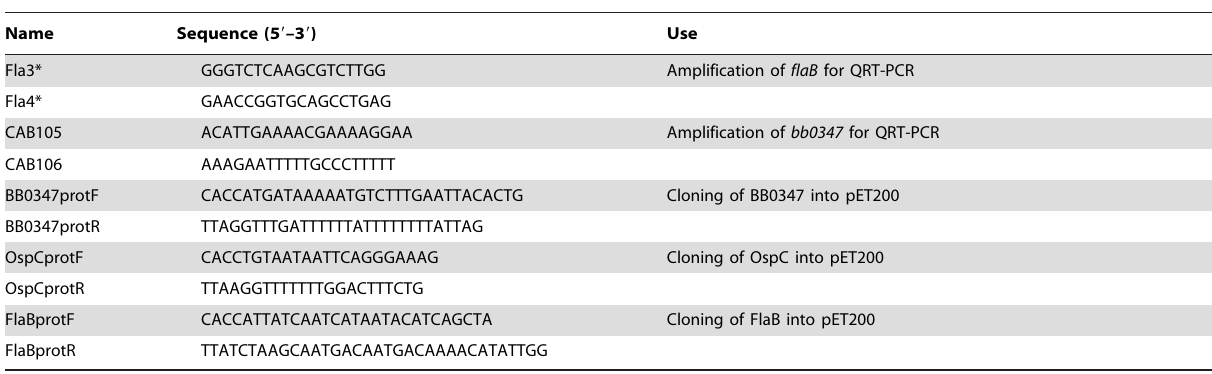
Table 1. Primers used in this